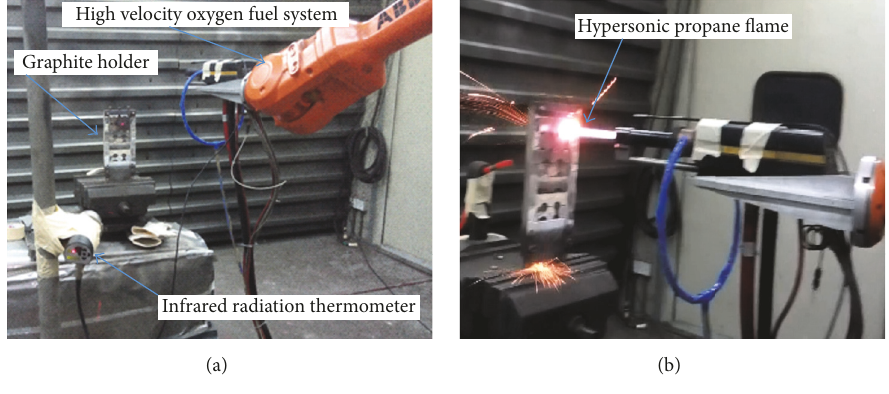
Figure 1: The high velocity oxygen fuel